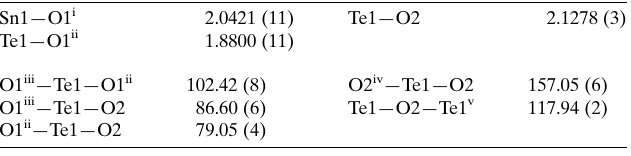
Table 1 Selected geometric parameters (A˚ , (cid:2) ).